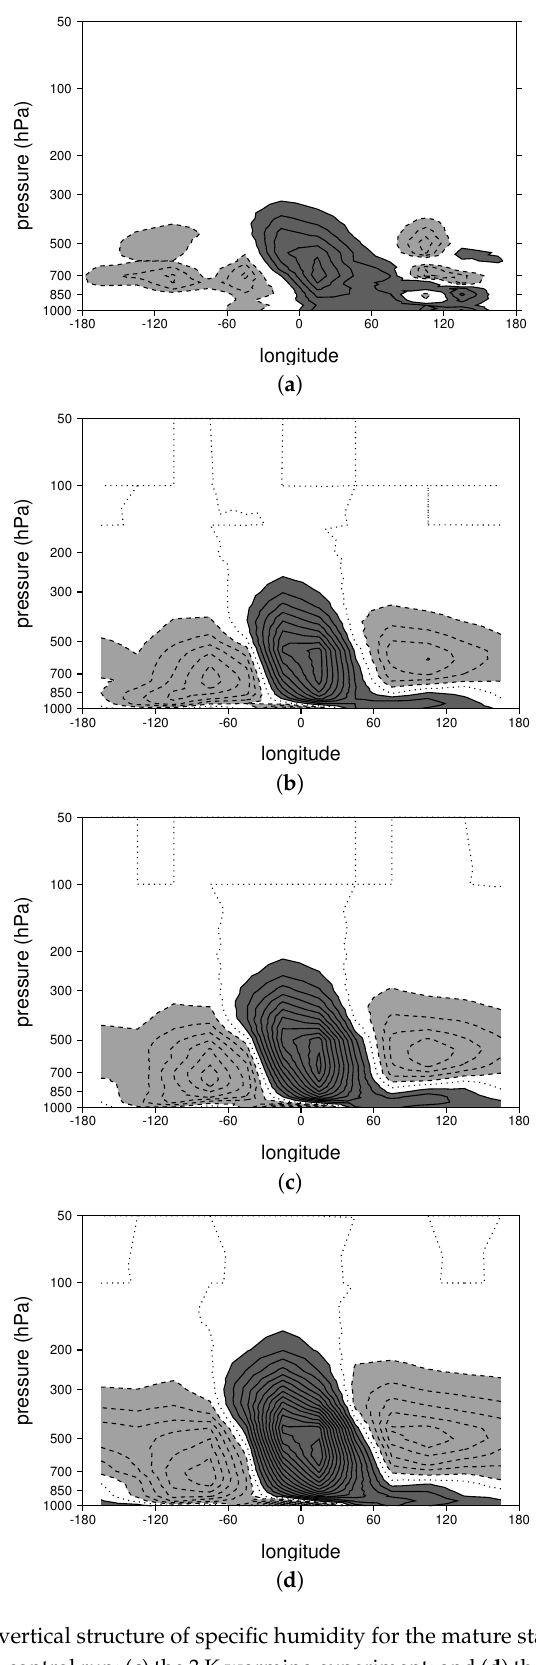
Figure 3. Composite vertical structure of specific humidity for the mature stage of the MJO for: ( a ) the observed MJO; ( b ) the control run; ( c ) the 3 K warming experiment; and ( d ) the 7 K warming experiment. The contour interval is 0.1 g/kg, and values greater (less) than 0.1 ( − 0.1) g/kg are shaded dark (light)